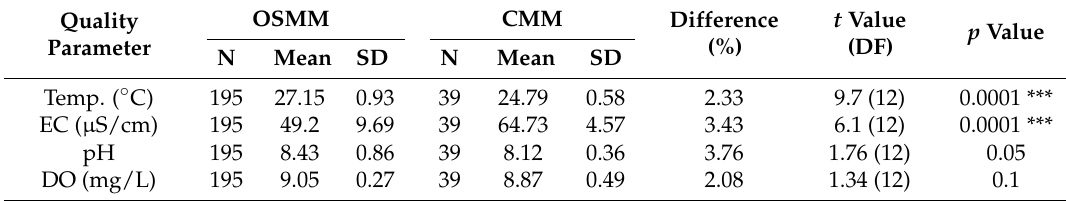
Table 2. Descriptive statistics for water quality parameters obtained by the OSMM and CMM.